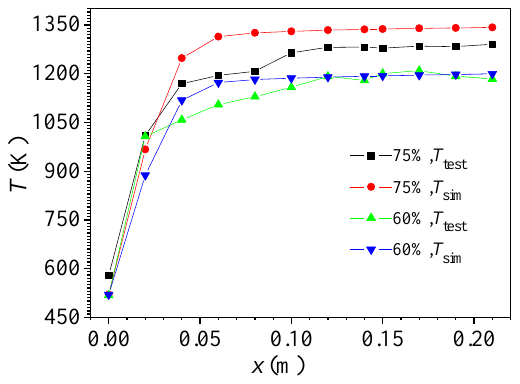
Figure 8. Comparison of flue gas temperature between test data and numerical results.